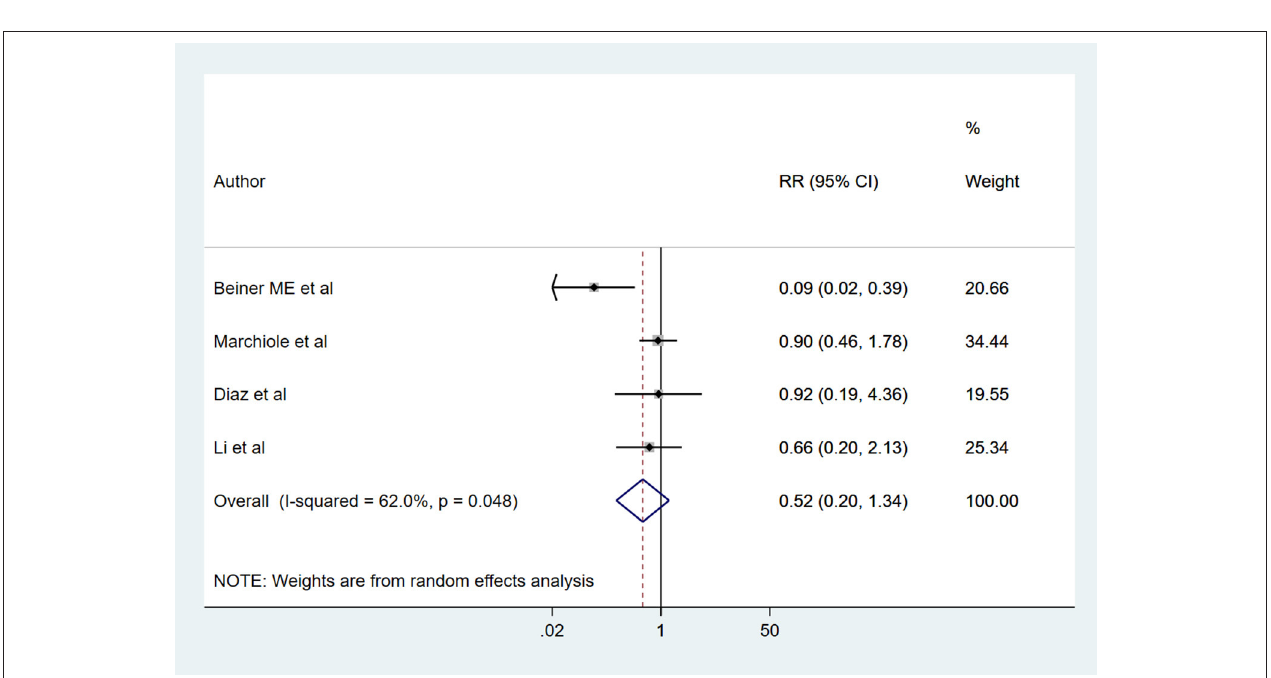
FIGURE 5 | The pooled effect size for the need for blood transfusion based on the comparison between radical trachelectomy and hysterectomy in patients with early-stage cervical cancer.